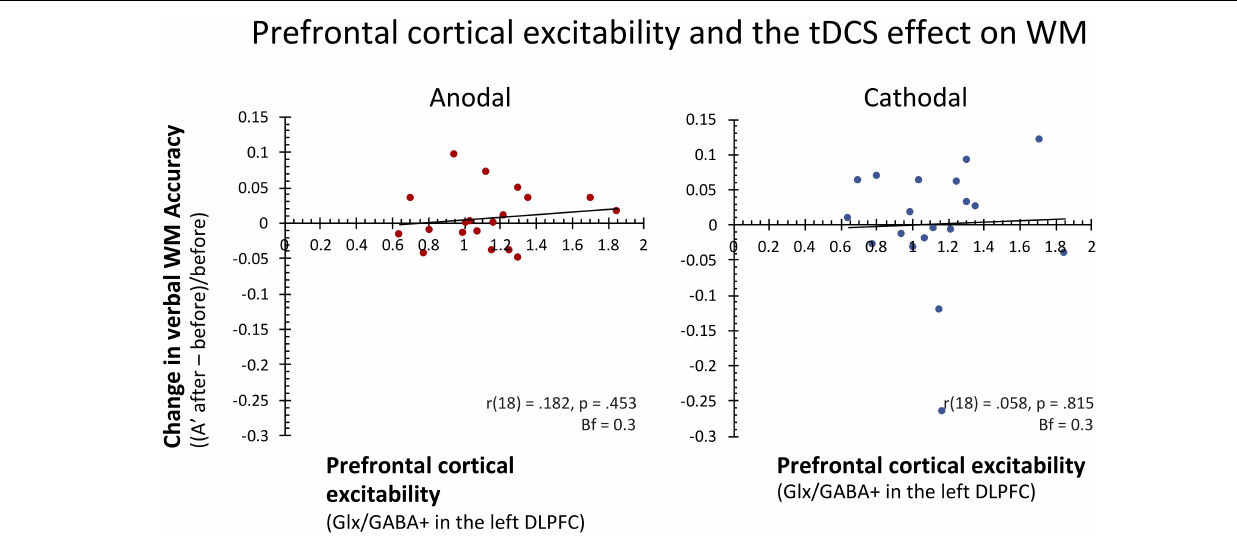
FIGURE 3 | In contrast to our expectations, baseline prefrontal cortical excitability (Glutamate/GABA ratios) did not predict individual differences in the extent and direction of the effects of anodal and cathodal tDCS on WM. As can be seen in these scatterplots, in both stimulation conditions about half the subjects showed improved verbal WM after stimulation, while the other half showed worsened performance. Pearson correlation coefficients and two-tailed p statistics are reported, as well as Bayes factors